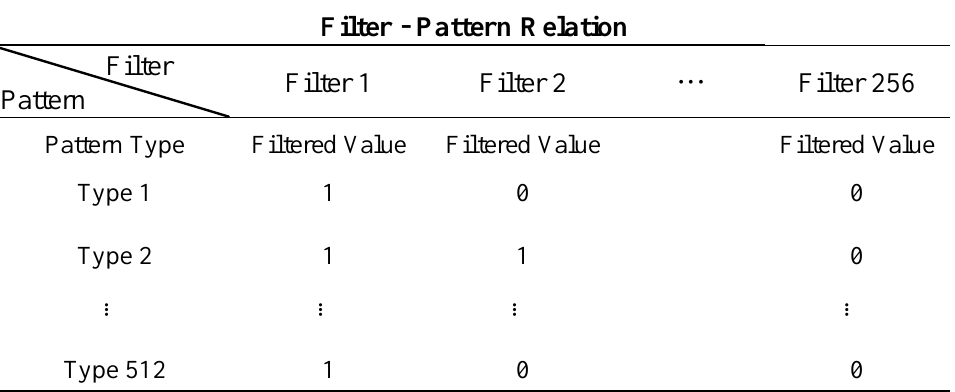
Table 1. Filter-pattern relation